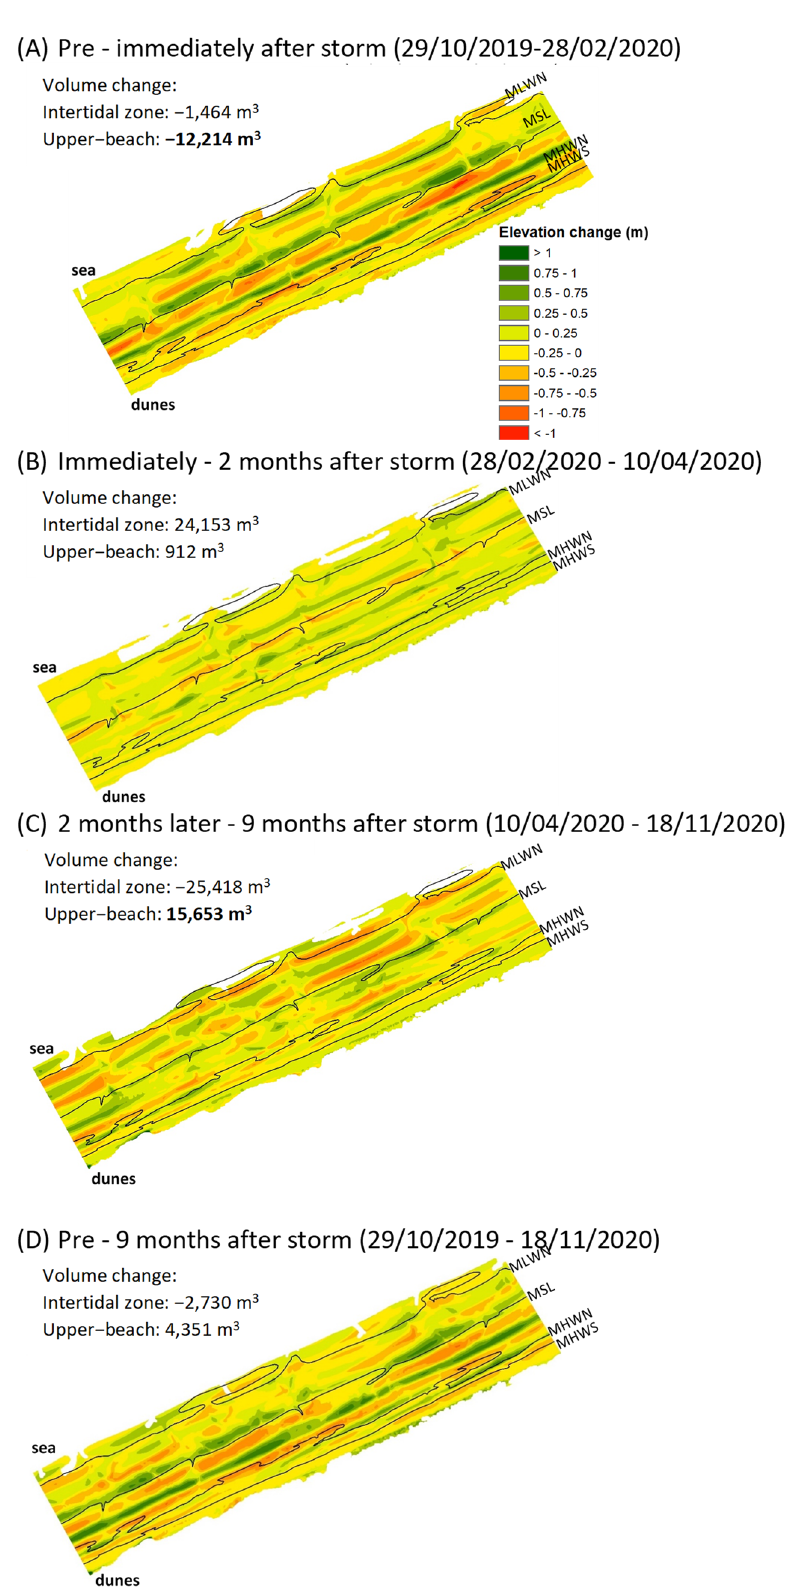
Figure 7. DoDs of pre- and post-storm surveys: ( A ) pre-storm—immediately later storm, ( B ) immediately—2 months later storm, ( C ) immediately—9 months later storm, ( D ) pre-storm—9 months later storm. For indication, the tidal reference levels on 29 October 2019 are added in black lines. The uncertainty errors on the intertidal zone and upper-beach per survey are estimated to be 40,150 m 3 and 4400 m 3 , respectively. Both are equivalent to an error on elevation difference of 0.05